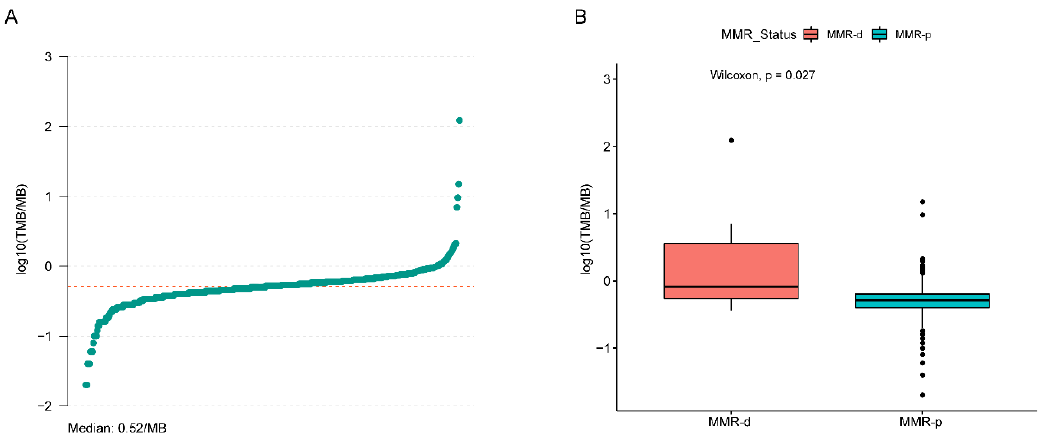
figure. MMR-d = mismatch repair-deficient; MMR-p = mismatch repair-proficient; Del = deletion; Ins = insertion.